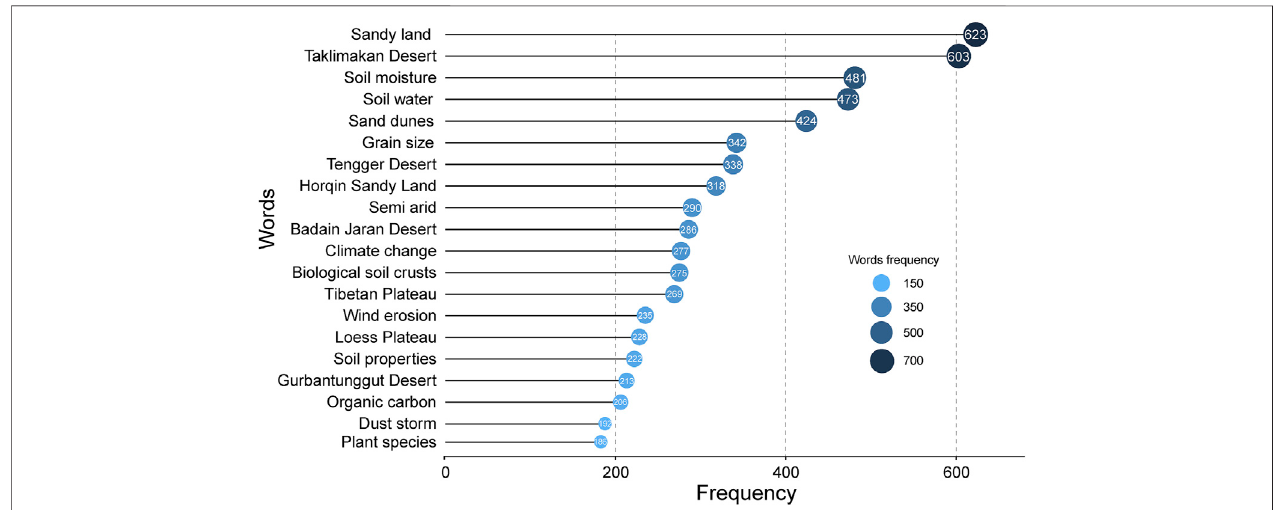
FIGURE 5 | The 20 most frequent keywords from 1986 to 2020. Word frequencies are listed in parentheses.